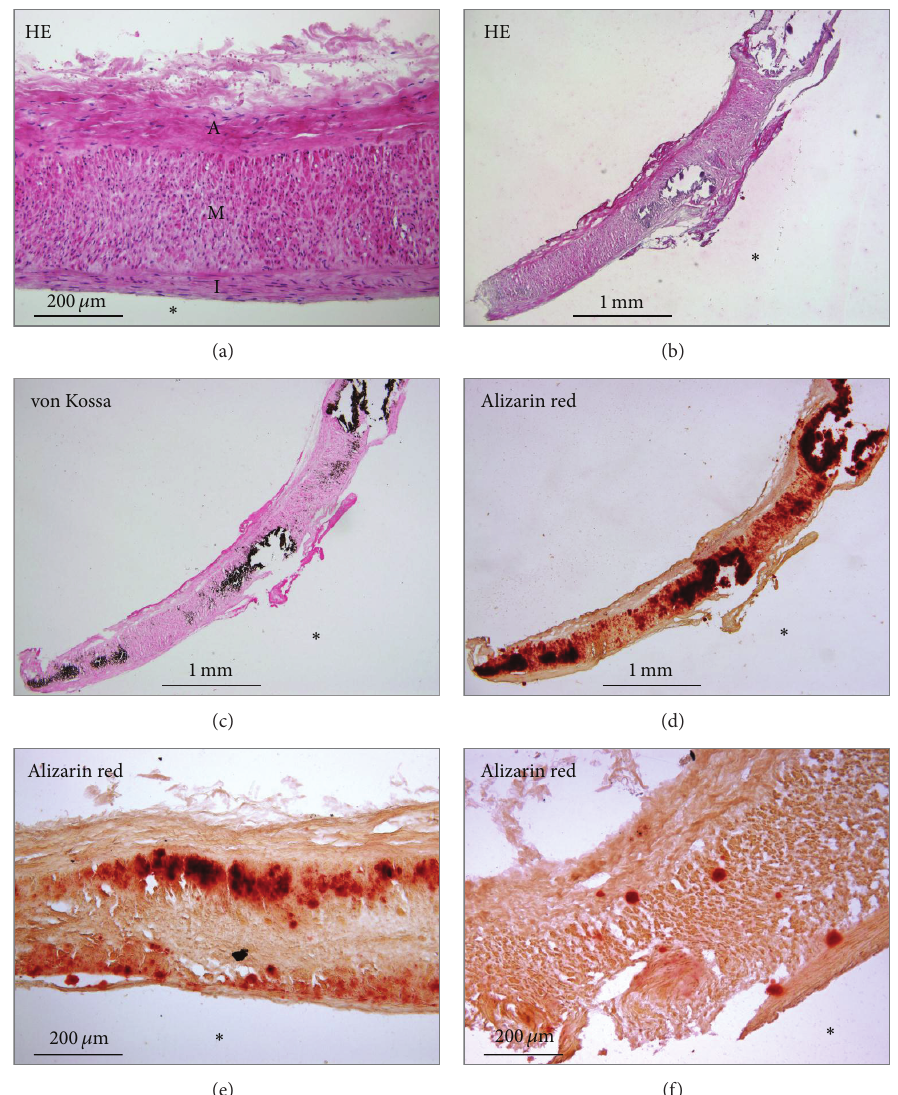
Figure 1: Histology of the radial artery samples. (a) Morphology of the routinely (HE) stained artery showing intimal thickening (I) and no mineral content. I: intima; M: media; A: adventitia. (b)–(d) Serial sections of the entire sample of the arterial wall demonstrating very advanced calcification (grade 4) stained with HE (b), von Kossa (c), and alizarin red (d). (e) Large granular calcifications (grade 3) localized on both sides of the media (alizarin red staining). (f) Small (grade 2) calcifications in the media (alizarin red staining). ∗ Lumen of the